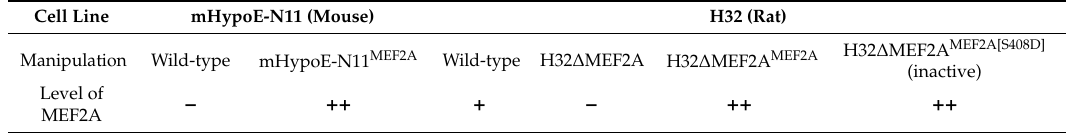
Table 1. Summary of cell lines used and created in this study. MEF2A protein levels have been assessed by means of Western blotting (Figure A3). mHypoE-N11 are derived from mouse hypothalamus neurons and lack endogenous MEF2A expression. Plasmid transfection caused MEF2A overexpression in those cells (mHypoE-N11 MEF2A ). H32 cells are immortalized neurons derived from a rat hypothalamus [48] and show moderate endogenous expression of MEF2A (wild-type). CRISPR-Cas directed knock out